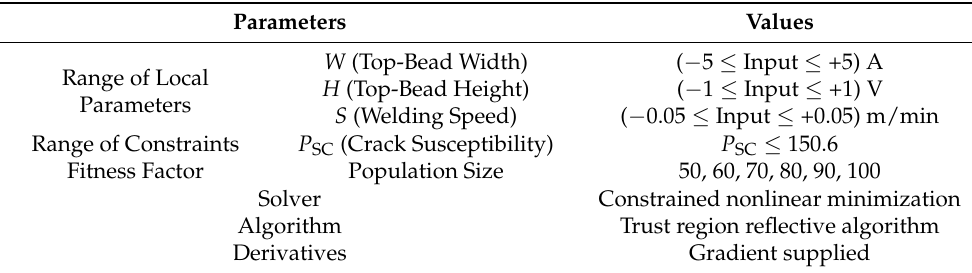
Figure 11. A flowchart of the Multi-Objective Optimization (MOO). Reprinted with permission from ref. [25]. Table 12. Parameters and their values for MOO.